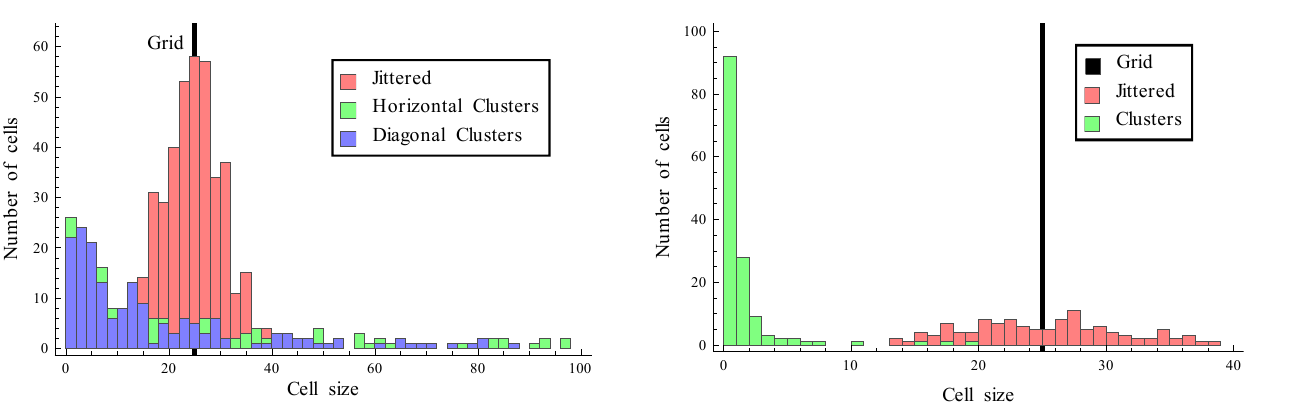
Figure 3. Tile size distribution for the three node distributions in START.